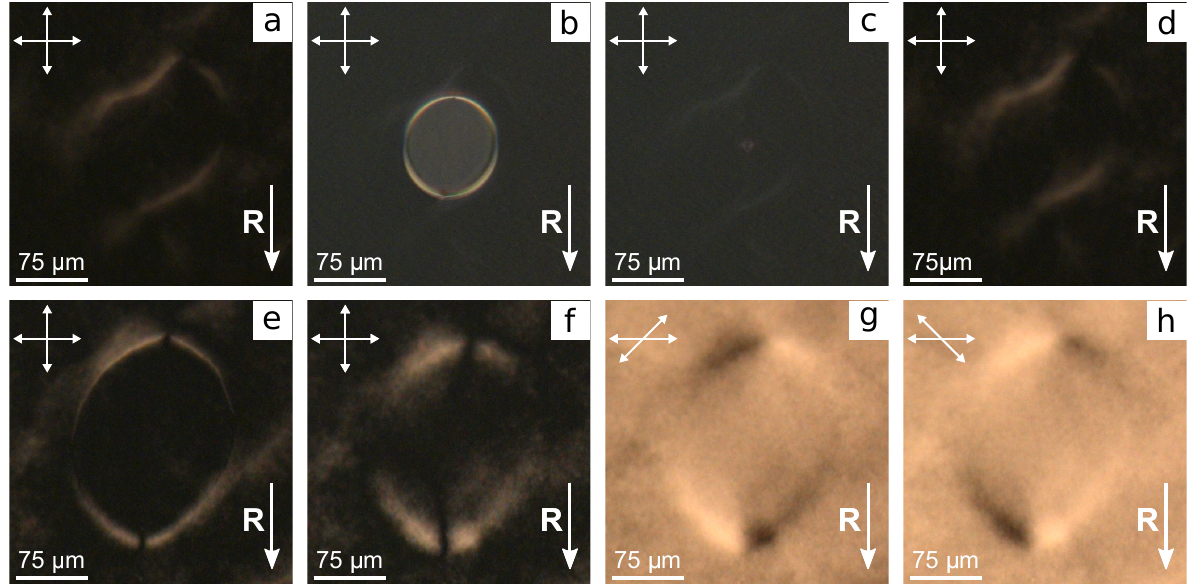
Figure 5. POM photos of two areas of LC cell with the bottom substrate covered with rubbed PVA film and the top substrate covered with a film of the polymer and LC mixture with weight ratio PiBMA:PMMA:LN-396 = 60:40:20. The first area ( a ) before, ( b ) in 40 s, ( c ) 80 s after voltage-on U = 6.0 V, and ( d ) after voltage-off. Photo of the second area ( e ) before and ( f – h ) after switching-off voltage U = 3.0 V. Photos are taken ( a – f ) in crossed polarizers, and at the angle between analyzer and polarizer ( g ) 45 ◦ and ( h ) − 45 ◦